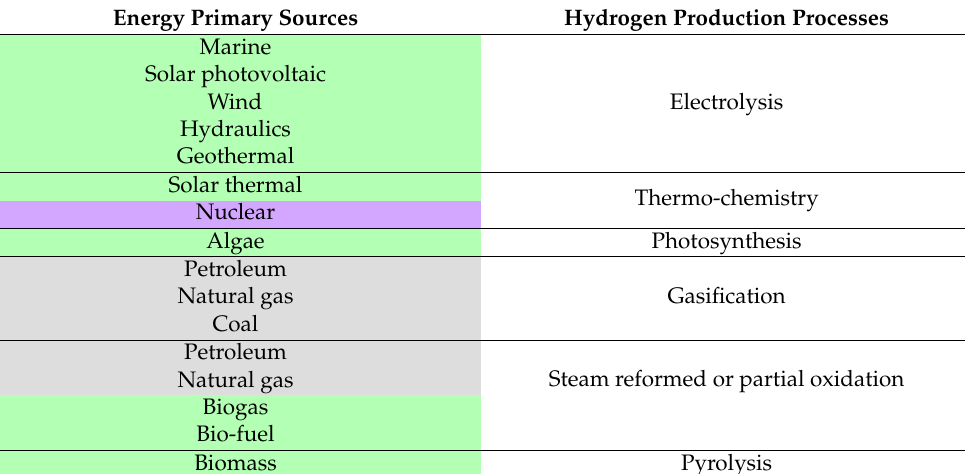
Table 1. Primary energy sources and more-developed techniques of hydrogen